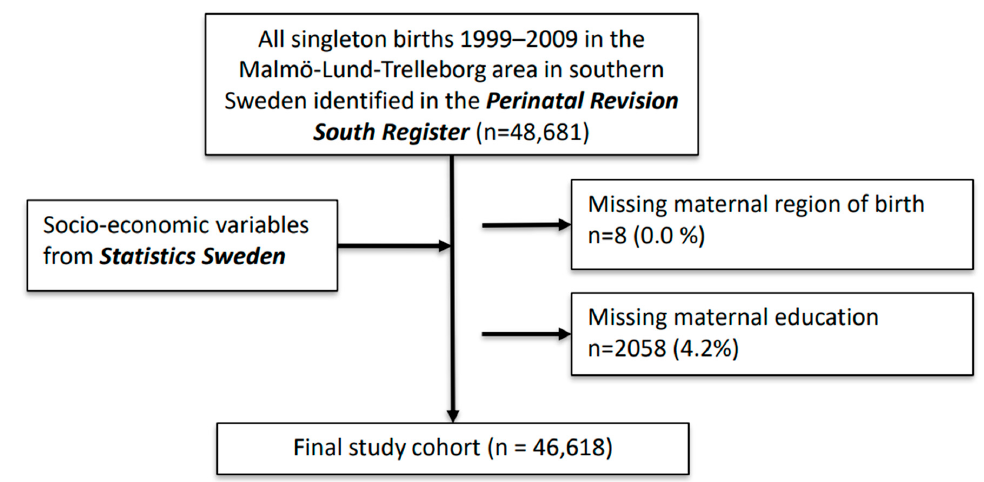
Figure 1. Flowchart depicting register linkage and how the final sample was